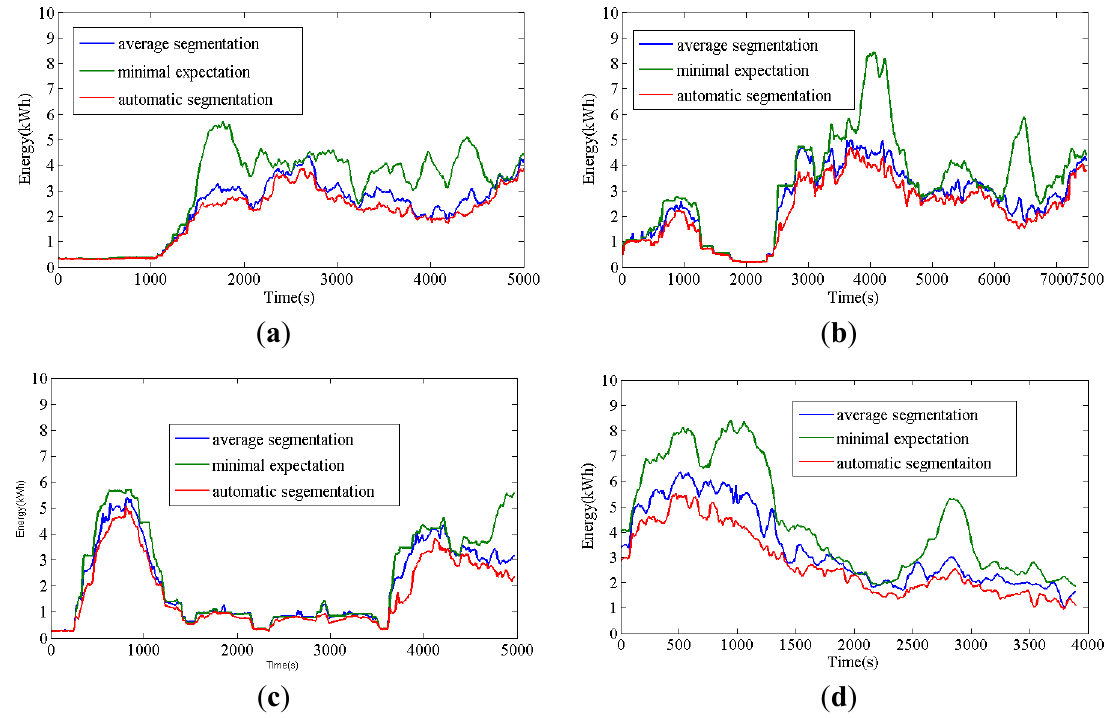
Figure 8. Capacity curves of